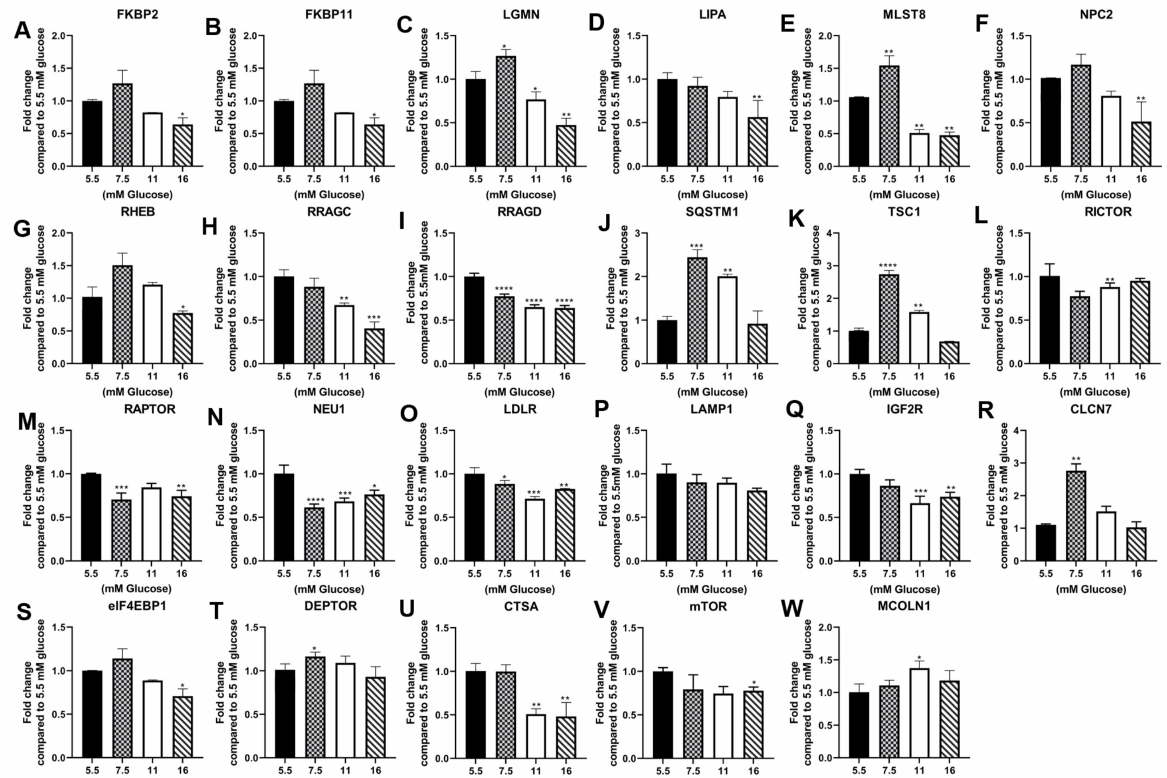
Figure 1. Expression of lysosomal and mTOR genes in RPTEC/TERT1 cells treated with 5.5 mM, 7.5 mM, 11 mM and 16 mM glucose for 3 passages. RT-qPCR analysis of ( A ) FKBP2; ( B ) FKBP11; ( C ) LGMN; ( D ) LIPA; ( E ) MLST8; ( F ) NPC2; ( G ) RHEB; ( H ) RRAGC; ( I ) RRAGD; ( J )